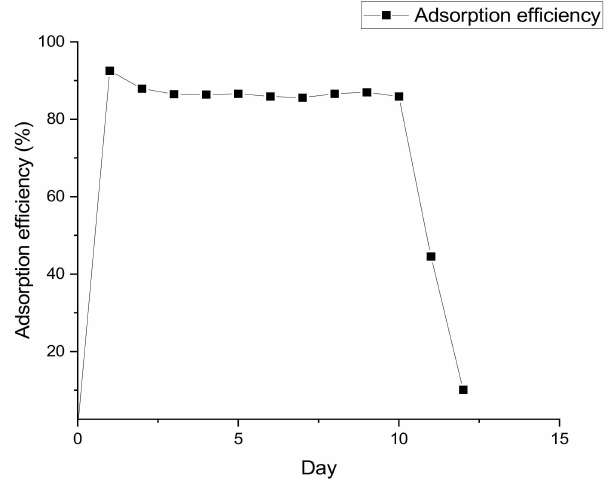
Figure 6. Column adsorption for 12 days (8 h/day) with a total of 2400 mL phosphorus solution (200 mg/L) with pH = 8. Table 1. Comparison of phosphorus adsorption capacity and sorption condition among various montmorillonite-based